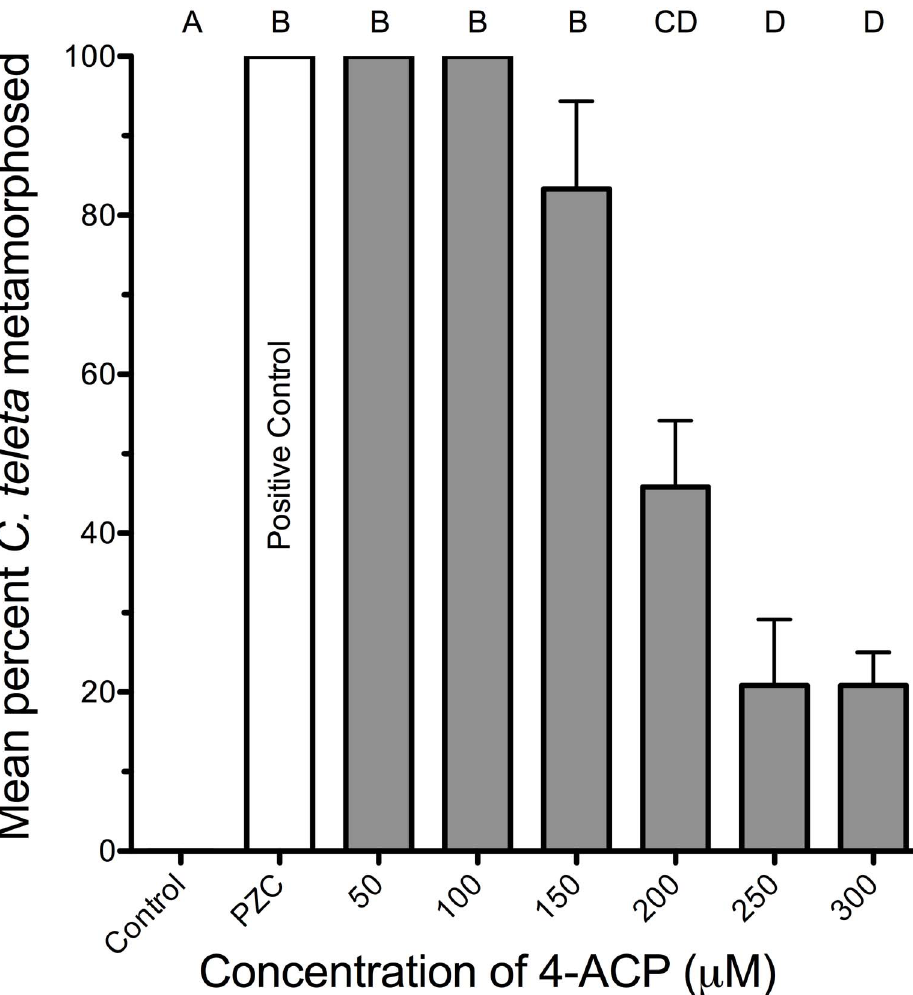
Figure 6. The inhibitory dose response of 4-acetylpyridine on metamorphosis of C.teleta after 24 h. Larvae were acclimated to the listed concentrations of 4-acetylpyridine (4-ACP) for one hour before being transferred to a solution of the same concentration of 4-acetylpyridine and pyrazinecarboxamide at 40 m M. Each treatment consisted of 3 replicates with 8 larvae per replicate. Artificial seawater (Instant Ocean) acted as a negative control. The PZC treatment acted as a positive control containing only 40 m M pyrazinecarboxamide and artificial seawater. Letters indicate significant (P , 0.05) differences as determined by a Bonferroni post-hoc test. Error bars represent + 1 s.e.m.